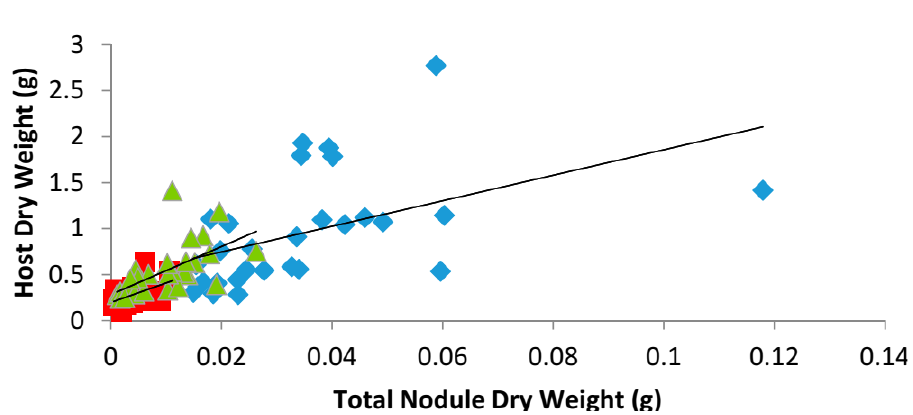
Figure 2. Relationships of host dry weight and nodule dry weight in the different pea lines; WT plants are represented by blue diamonds, E107 plants by red squares, and E132 plants by green triangles. Plants were harvested throughout their development (at 14, 21, 38, 35, and 42 DAI), and data from all ages were taken into consideration (i.e., n = at least 24 for each pea line) to perform the regression analysis.